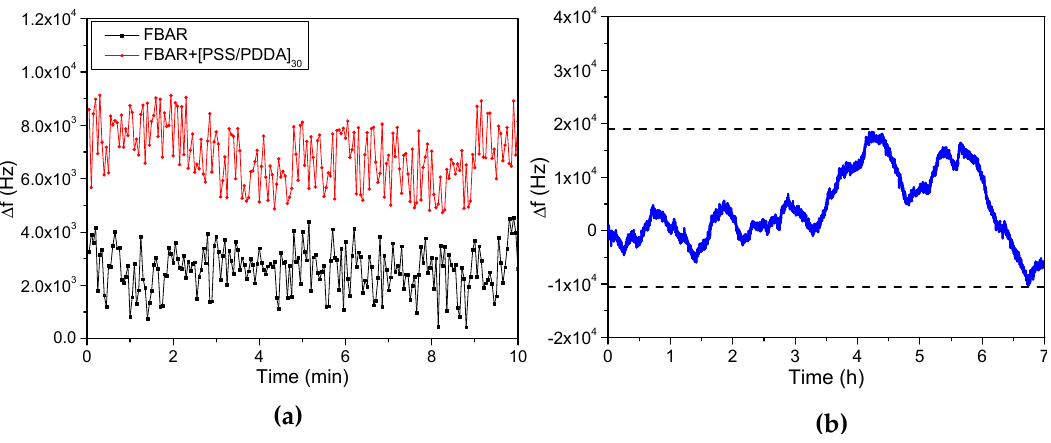
Figure 8. Noise and stability measurements of FBAR at ambient conditions. ( a ) Noise of both FBAR without coating and FBAR coated with 30 PSS/PDDA bilayers; ( b ) frequency drift of FBAR coated with 30 PSS/PDDA bilayers.